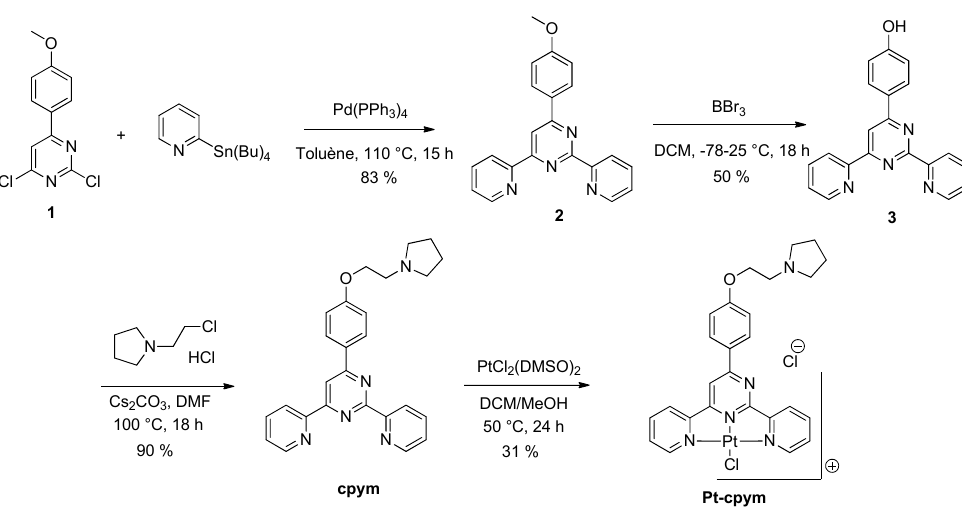
Scheme 2. The synthesis of Pt-cpym .